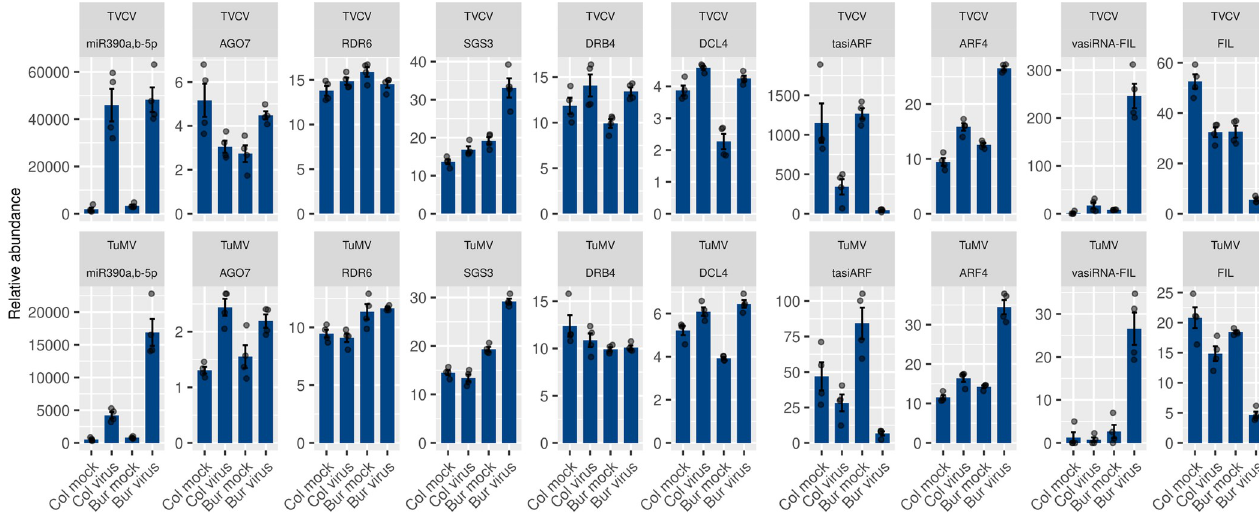
Fig 10. Expression pattern of the TAS3 regulatory module components. The normalized expression values of the sRNAs and genes involved in the TAS3 regulatory module are shown in the TVCV and TuMV series. Error bars represent the standard error of the mean of four biological replicates. The actual data points are also